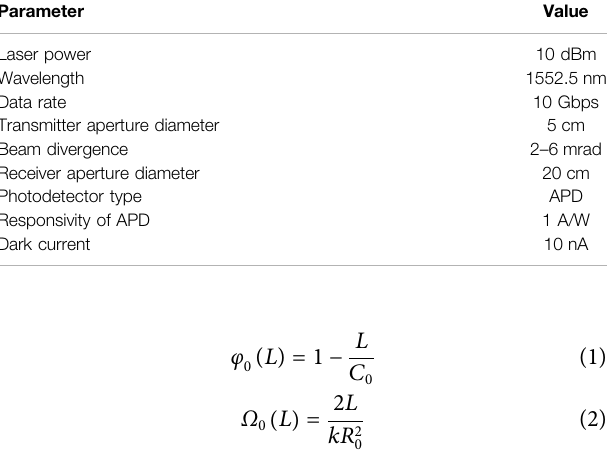
TABLE 1 | Link Parameters of the proposed FSO system [17, 20, 32 –